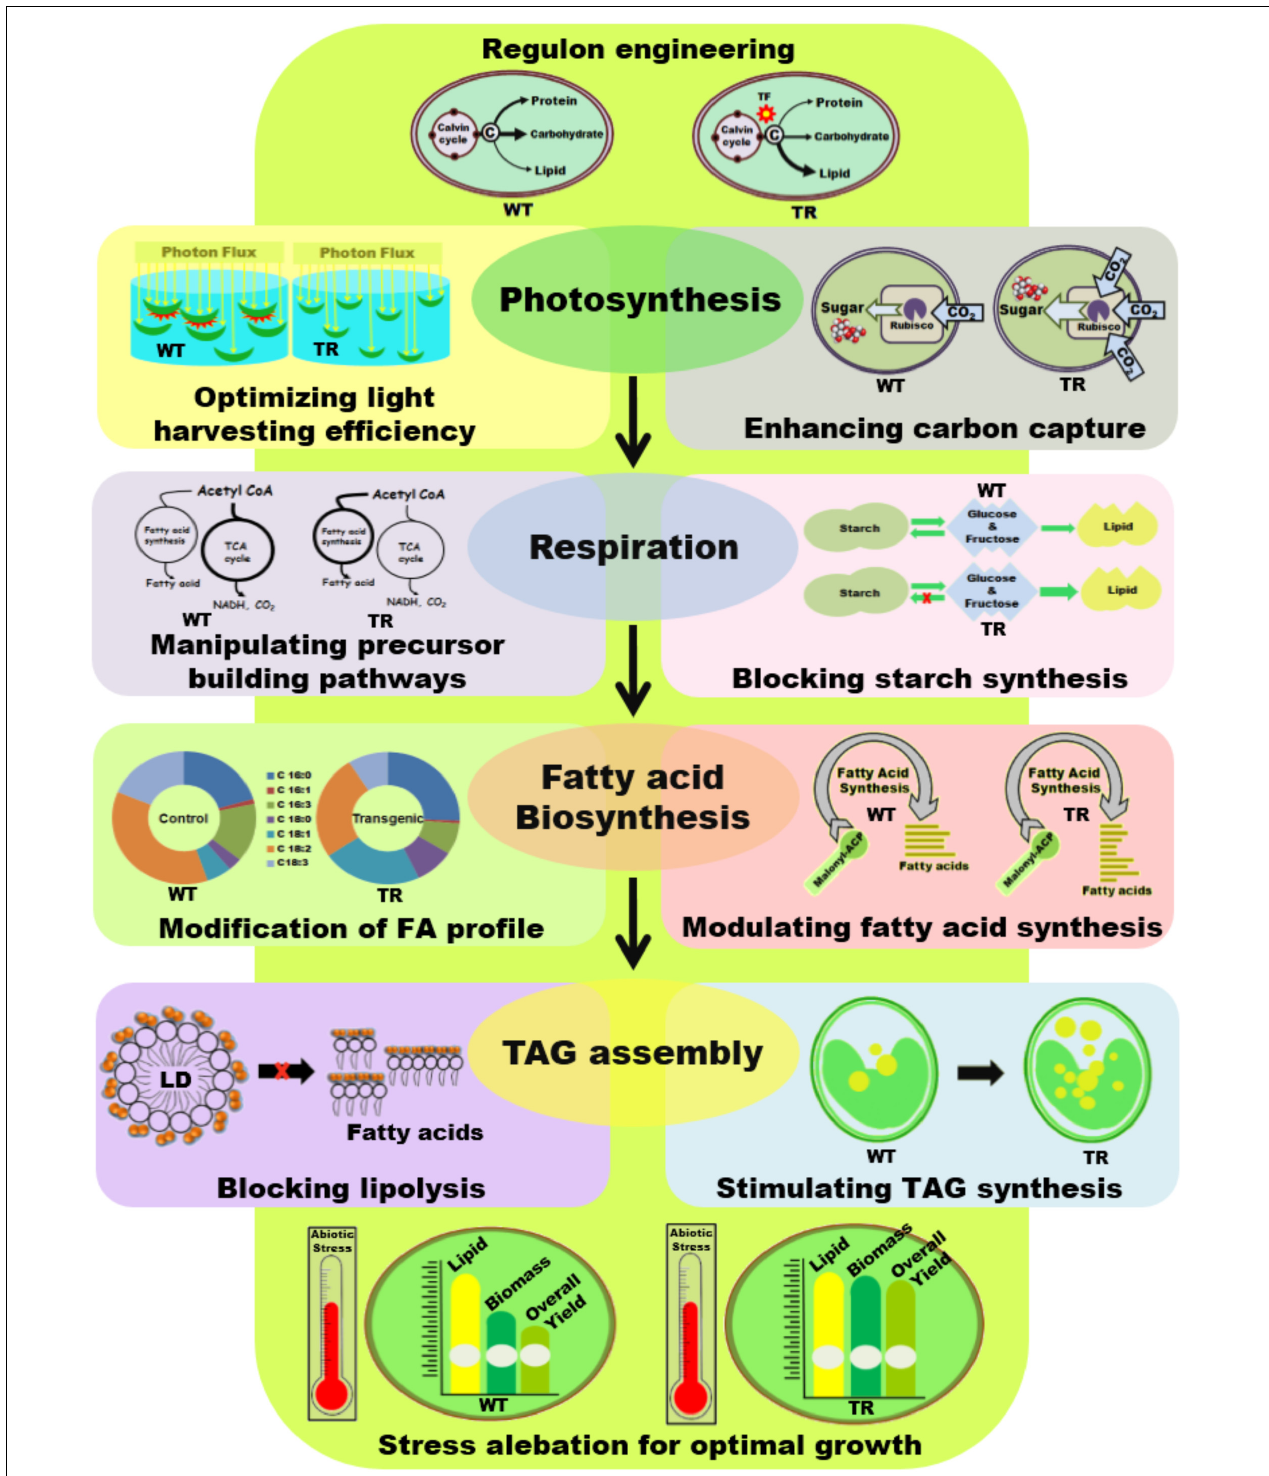
FIGURE 2 | Schematic illustration of different genetic engineering strategies applied in microalgae for biodiesel application. WT, Wild type cells; TR, Transgenic cells; TF, Transcription factor; TCA, Tricarboxylic acid cycle; NADH, Nicotinamide adenine dinucleotide; FA, Fatty acid; LD, Lipid droplet.